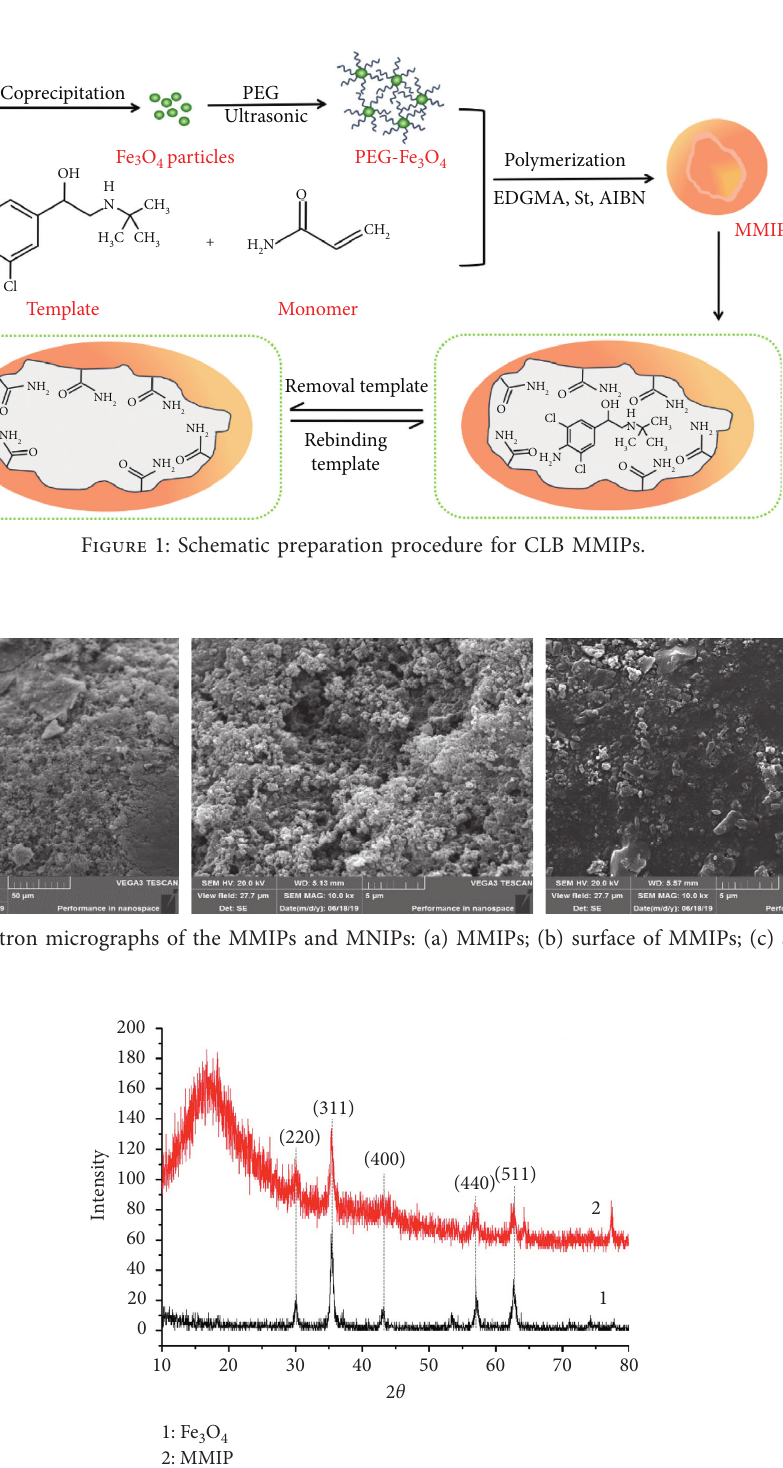
3 O 4 (1) and MMIPs